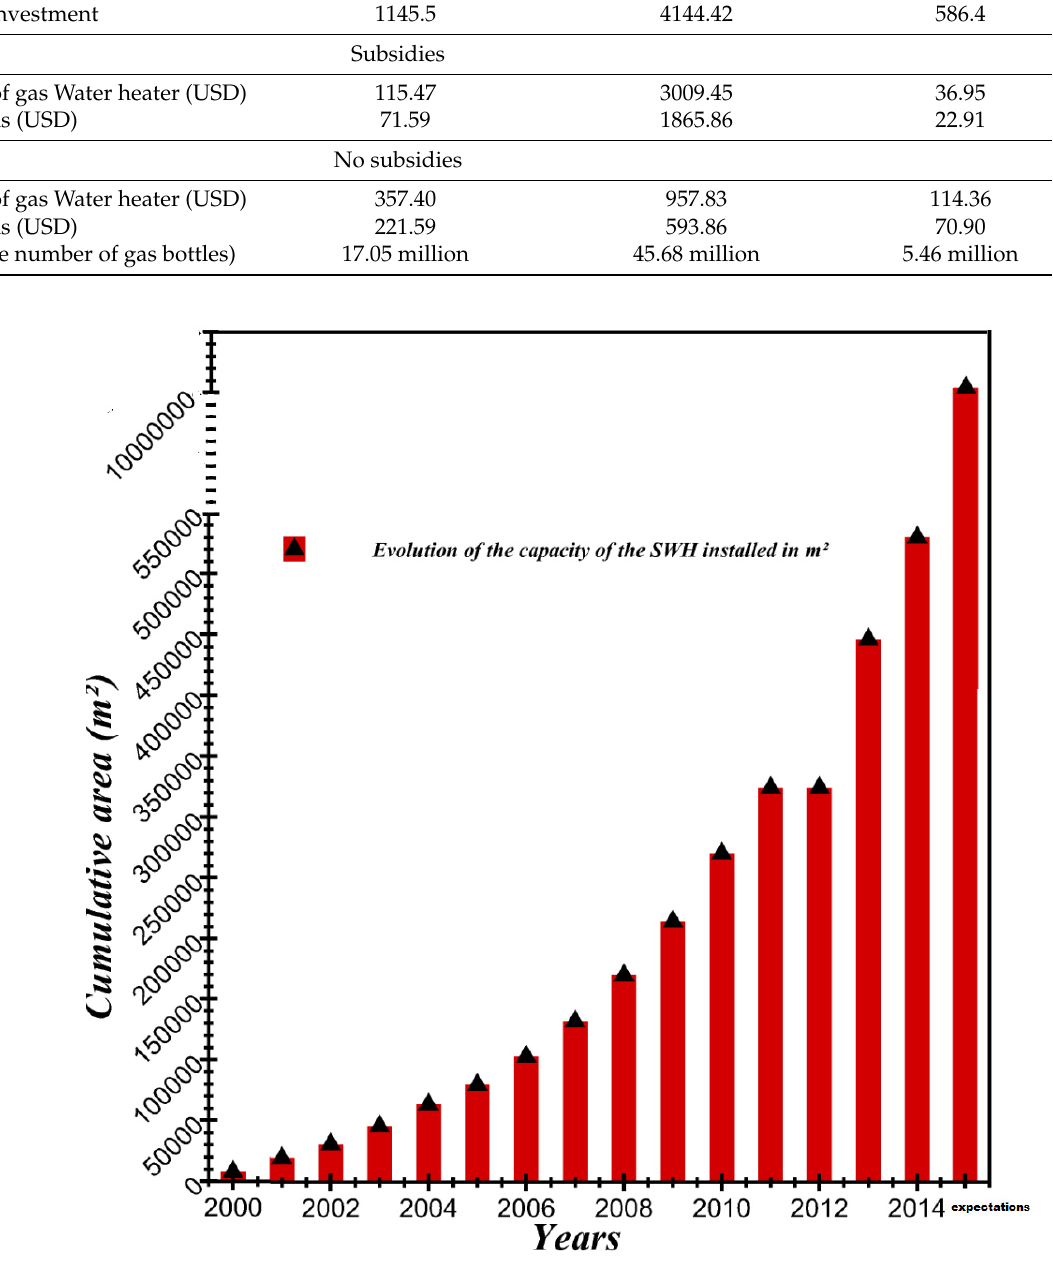
Figure 16. Cumulative area of the SWH installed in Morocco since 2000 and expectations. Table 9. The total gains for different type of houses according to the two scenarios (with and without subsidies). Type of House